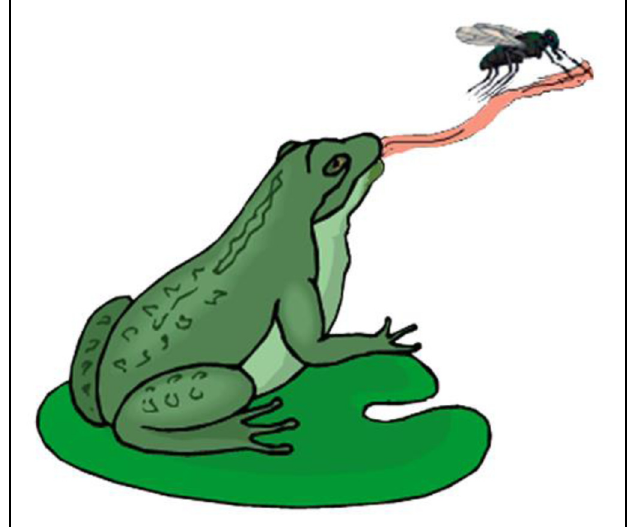
FIGURE 1 | Example of a target picture